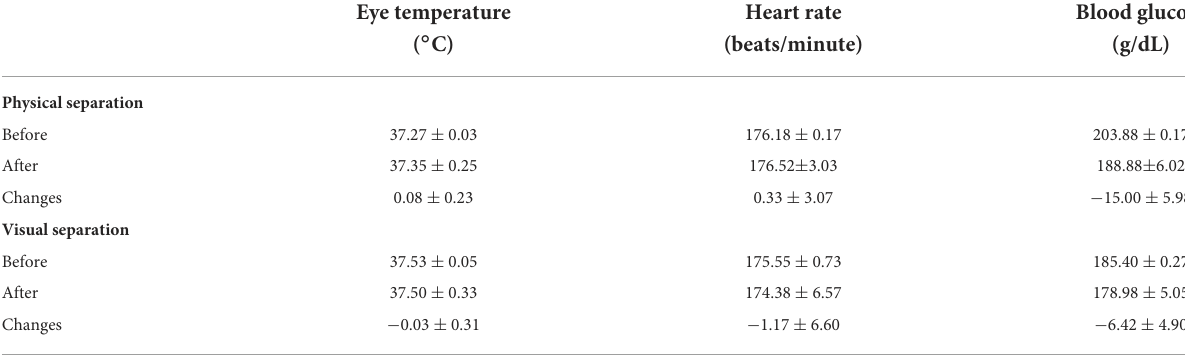
TABLE 2 Physiological responses, actual values, and changes (after separation minus before separation) of Nigerian indigenous hens to physical and visual separation from their